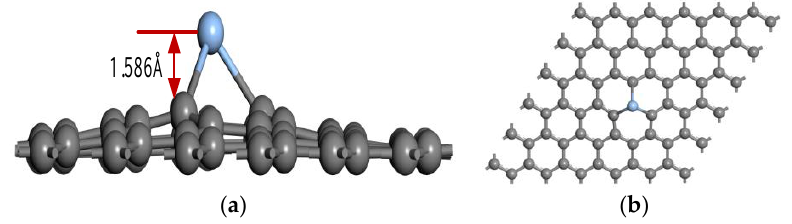
Figure 3. Partial atomic structure of ( a ) side view and ( b ) top view for the Ag-C T doping graphene surface.